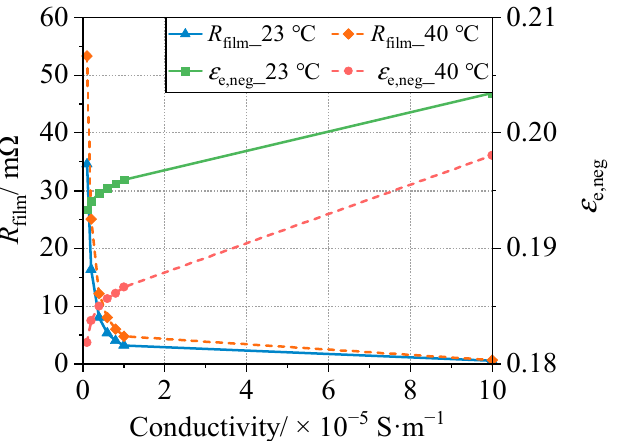
Figure 11. Simulation results of the SEI resistance and negative porosity of the cell after aging when using different SEI ionic conductivities.